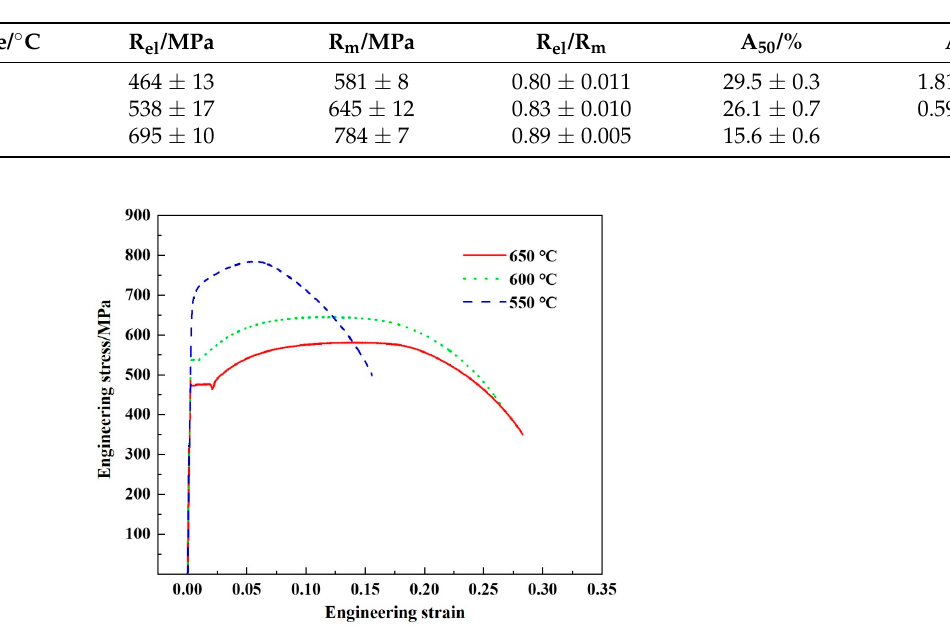
Figure 4. Engineering stress–strain curves of test steel at di ff erent coiling temperatures.